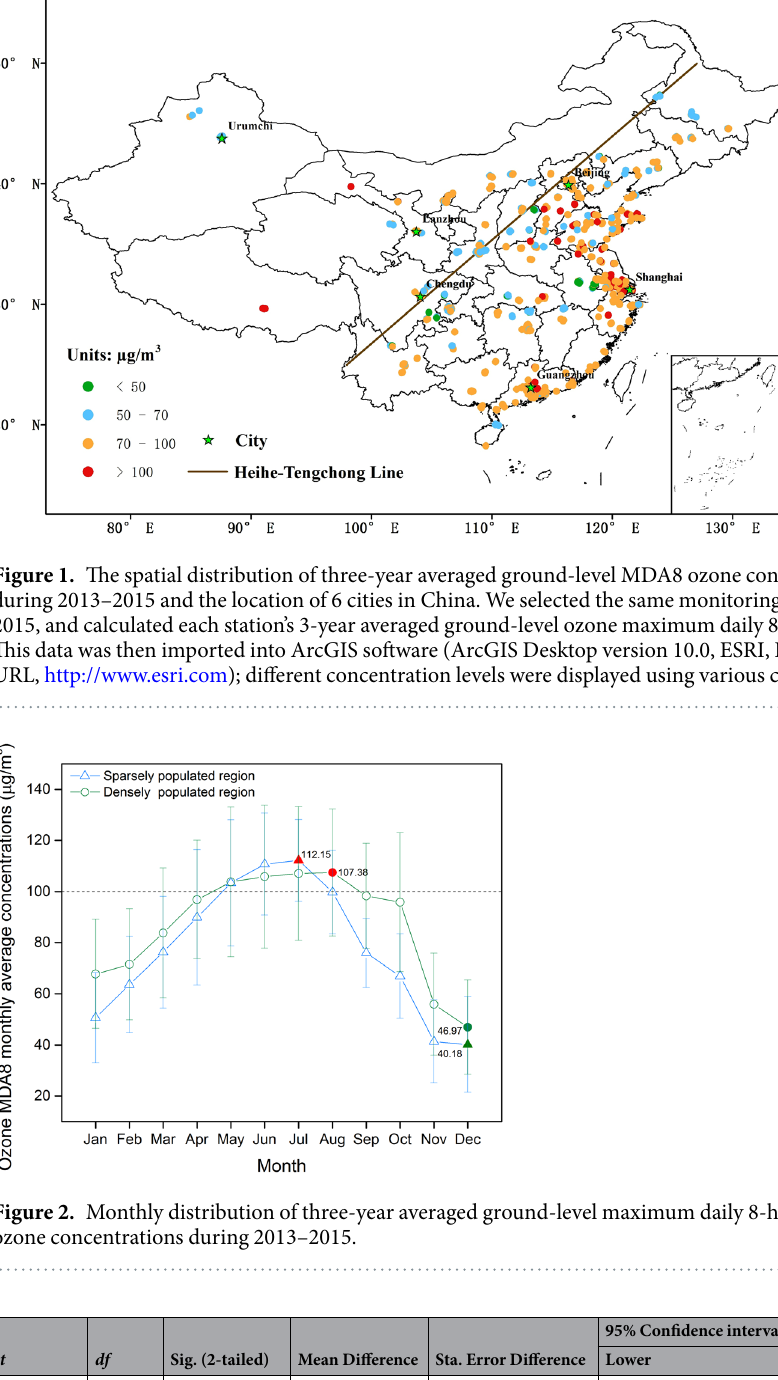
t df Sig. (2-tailed) Mean Difference Sta. Error Difference